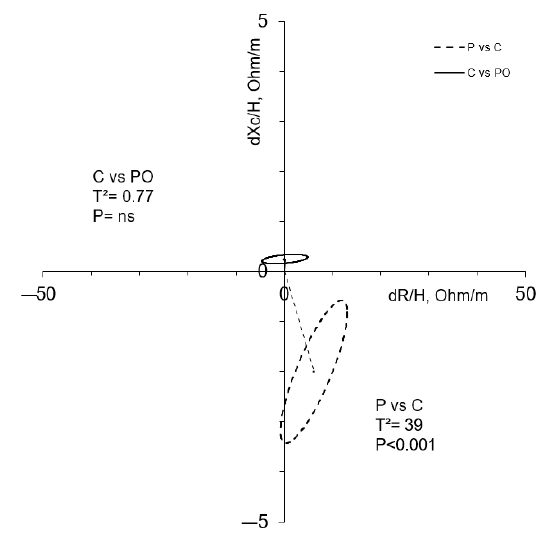
Figure 2. Mean displacements vector and Hotelling’s T² test results of total population.